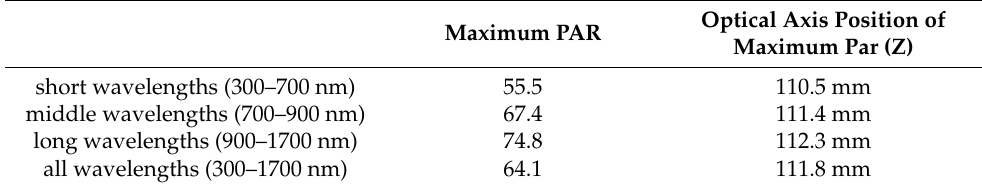
Table 2. The optical axis position of the maximum peak-to-average ratio (PAR) of different wave-